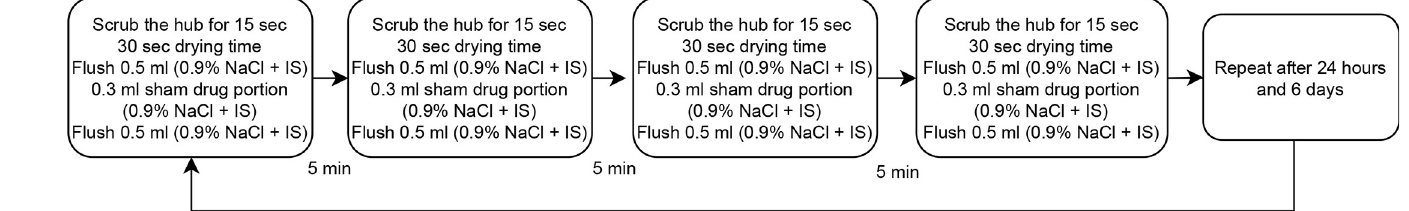
Fig 3. Injection scheme for scrub circuits. IS = Internal